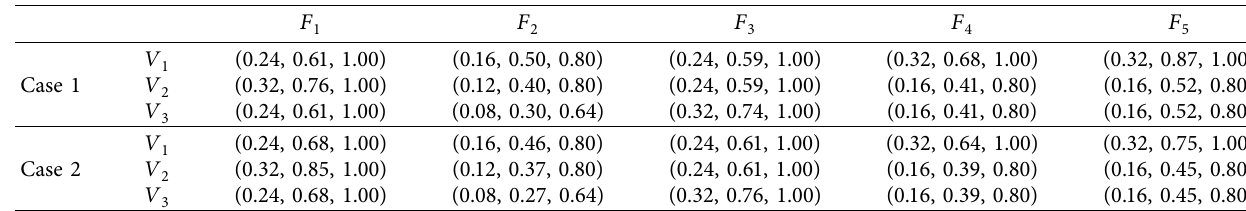
Table 3: Fuzzy weighted decision matrix.